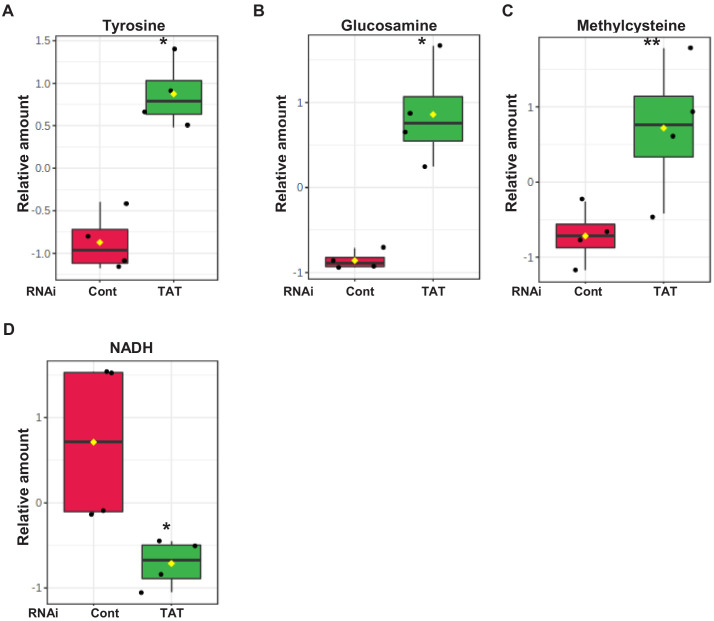
Neuronal-specific downregulation of Tyrosine Aminotransferase/TAT leads to metabolic reprogramming similar to the whole-body downregulation of TAT.Box plots of relative levels of tyrosine (A), glucosamine (B), methylcysteine (C), and NADH (D) in elav-Gal4,tubulin-Gal80ts flies expressing either control RNAi or TAT RNAi. FDR adjusted p-value. *p<0.05, **p<0.01.